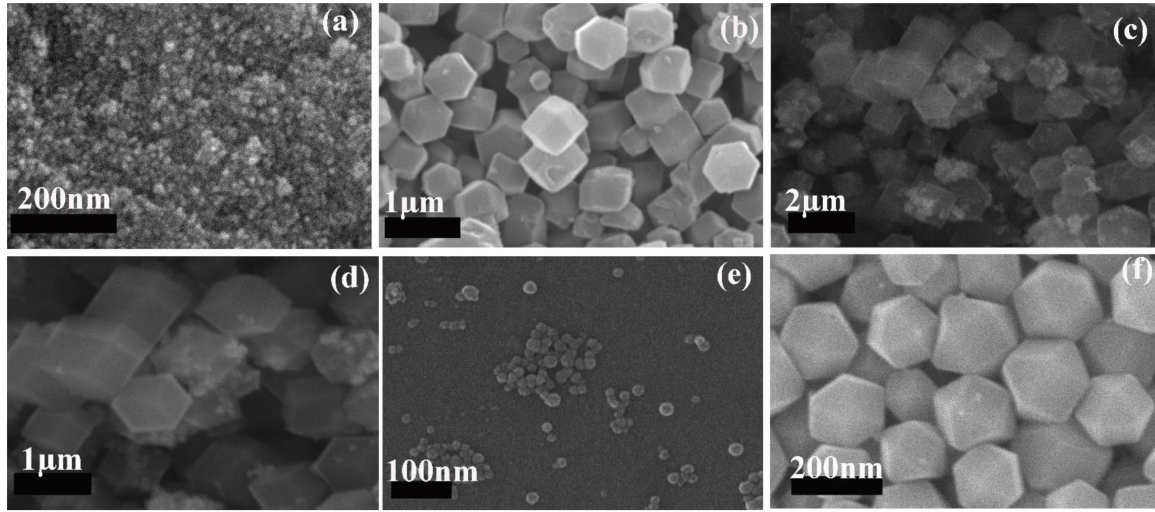
Figure 2. SEM images of ( a ) pure CeO 2 ( b ) pure ZIF-67 ( c , d ) low- and high-resolution SEM of ZIF-67/CeO 2 ( e ) 10% Cu doped CeO 2 ( f ) 90% Cu doped CeO 2